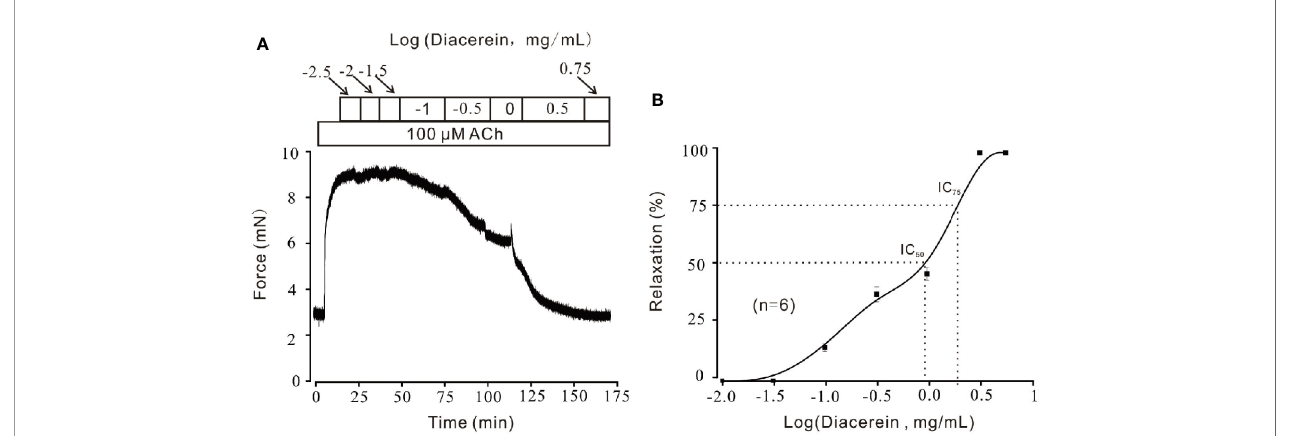
FIGURE 4 | Relaxant effects of diacerein on ACh-precontracted mouse tracheal rings (mTRs). (A) A representative tension record indicated that ACh induced a steady contraction which could be inhibited by 0.1~3.16 mg/ml diacerein in a dose-dependent manner. (B) Dose-relaxation curve of diacerein on high K + - precontracted mTRs (n = 6/6 mice).